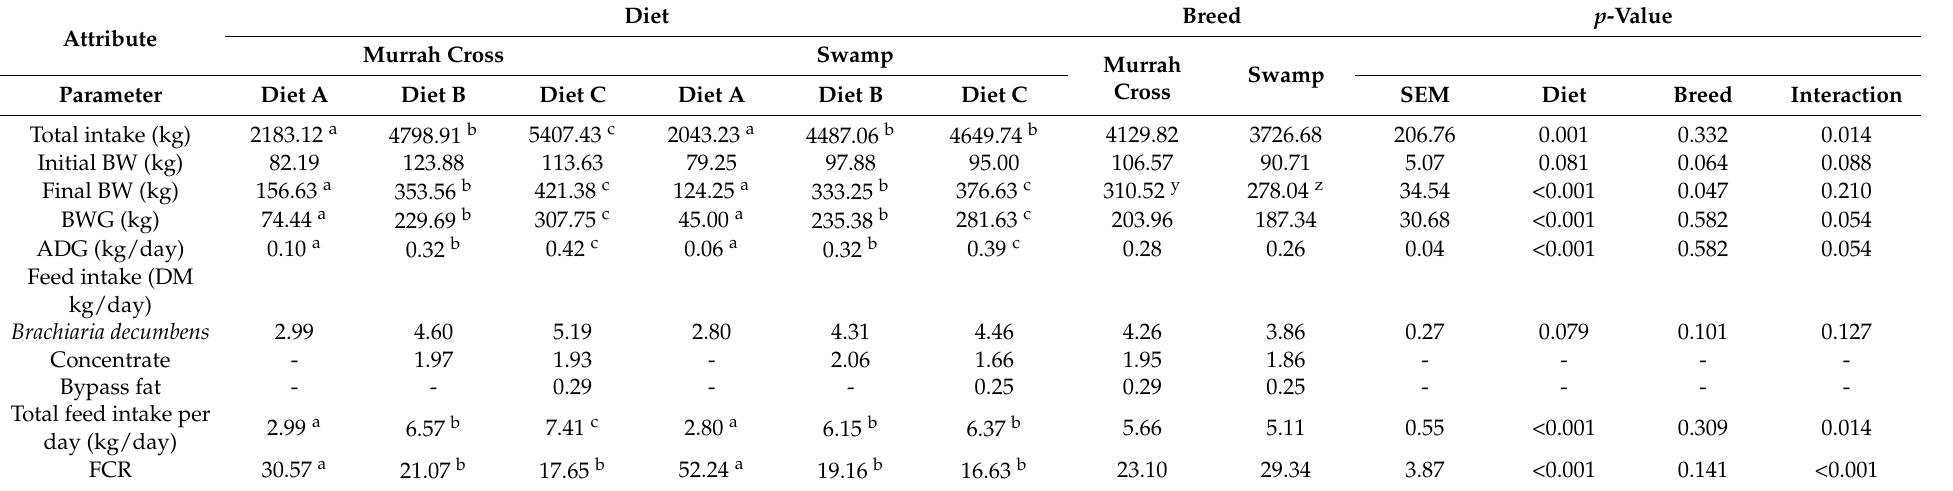
Table 3. Feed intake, body weight gain (BWG), average daily gain (ADG), and feed conversion ratio (FCR) of buffaloes fed with and without supplement over two-year experiment.